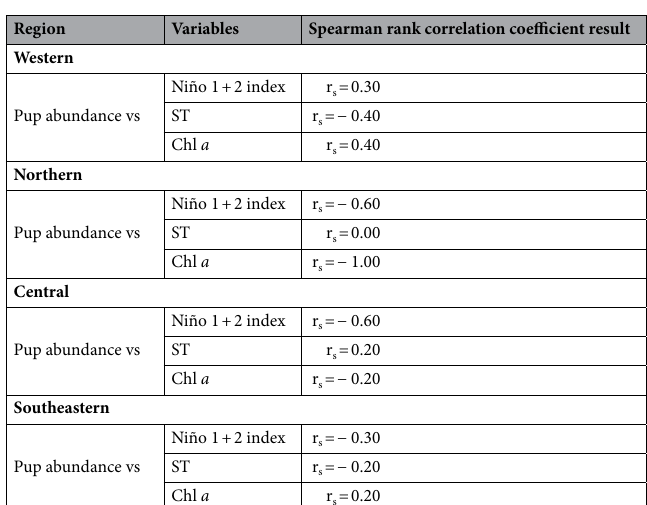
Table 5. Spearman’s rank correlation coefficient results. Relationships between Galapagos sea lion pup abundance per region of the archipelago and environmental variables from 2014 to 2018 for Niño 1 + 2 index and without 2017 data for subthermocline temperature (ST) and Chlorophyll-a (Chl a ) No relationship was significant at p = 0.05.